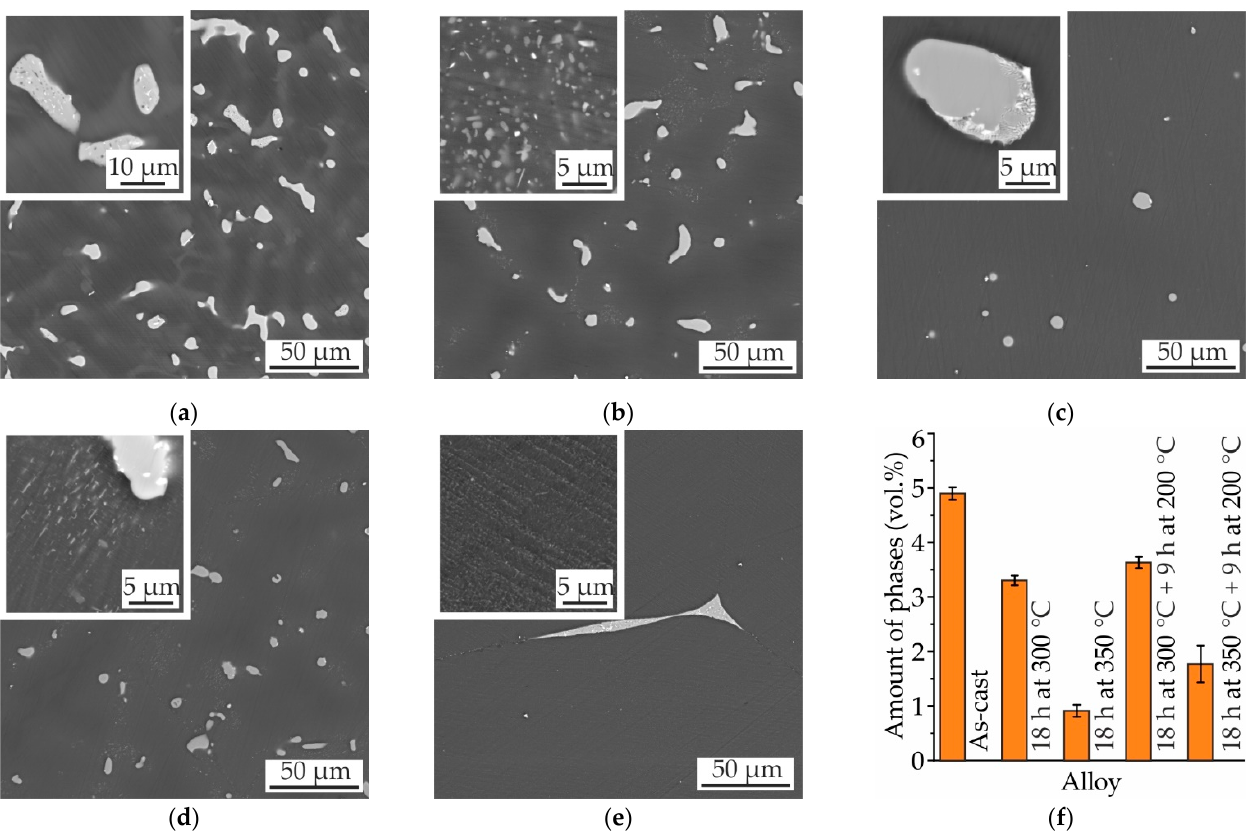
Figure 6. SEM micrographs of MgZn4Ga4: ( a ) as-cast; after T4 heat treatment: ( b ) 18 h at 300 °C, ( c ) 18 h at 350 °C; and after T6 heat treatment: ( d ) 18 h at 300 °C and 9 h at 200 °C, ( e ) 18 h at 350 °C and 9 h at 200 °C; and ( f ) the amount of intermetallic phases (Mg 7 Zn 3 and Mg 5 Ga 2 ) in these conditions.